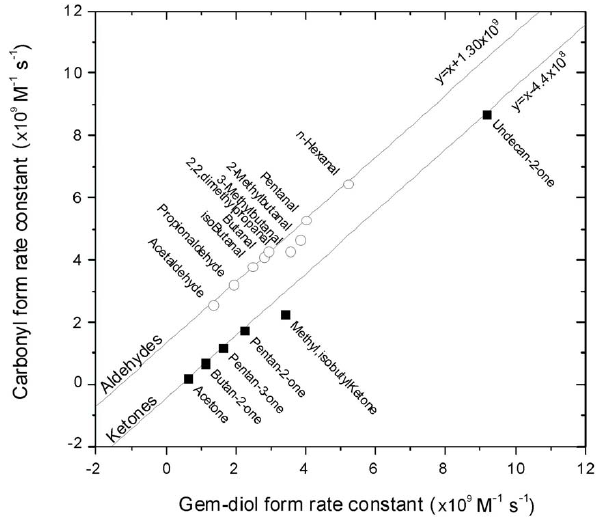
Fig. 3. Correlation plot between gem-diols and carbonyl compound Figure 3: Correlation plot between gem-diols and carbonyl compounds rate constants as calculated 2 rate constants as calculated from the present from the present SAR. 3